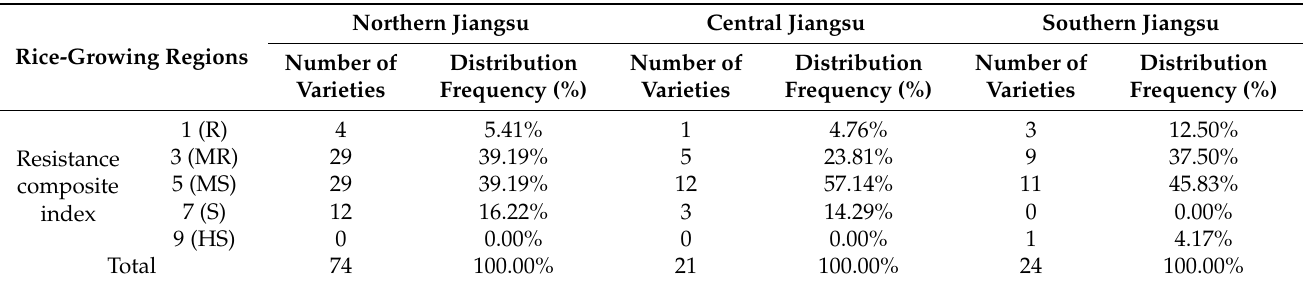
Figure 2. The resistance level and 14 R genes detection of 119 rice main varieties. ( A ) The resistance level of 119 rice main varieties. ( B ) The number of R genes present in 119 rice main varieties. ( C ) The relationship between the number of R genes and resistance level. ( D ) The distribution of 14 R genes in 119 rice main varieties. Table 1. The resistance composite index of 119 rice main varieties in three regions of Jiangsu